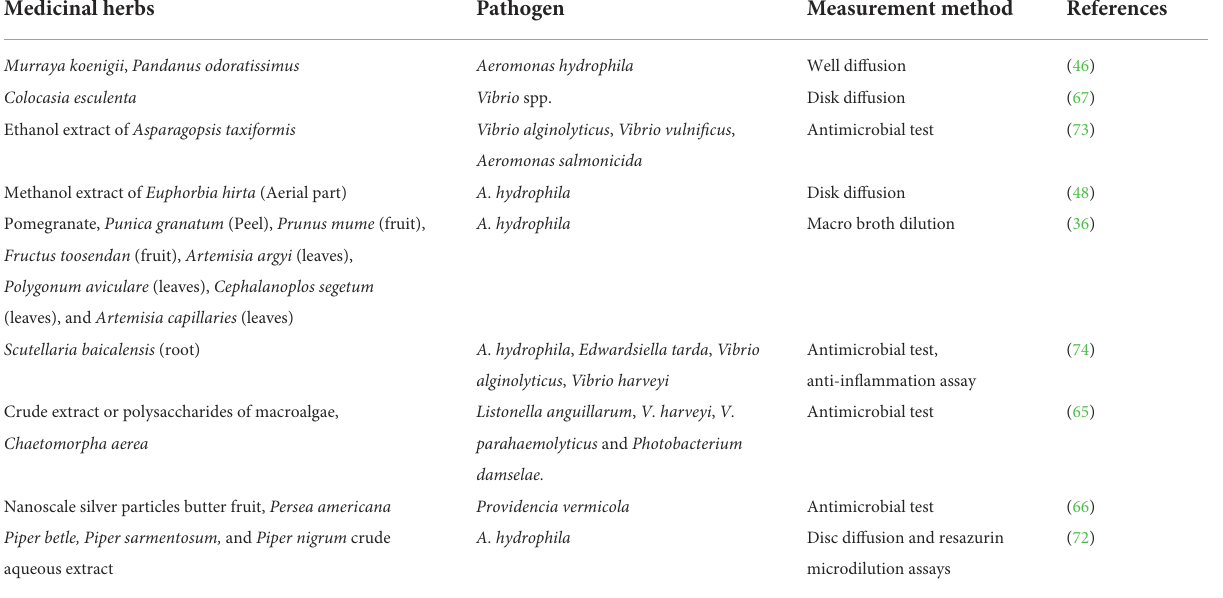
TABLE 2 Antibacterial activities of medicinal herbs in